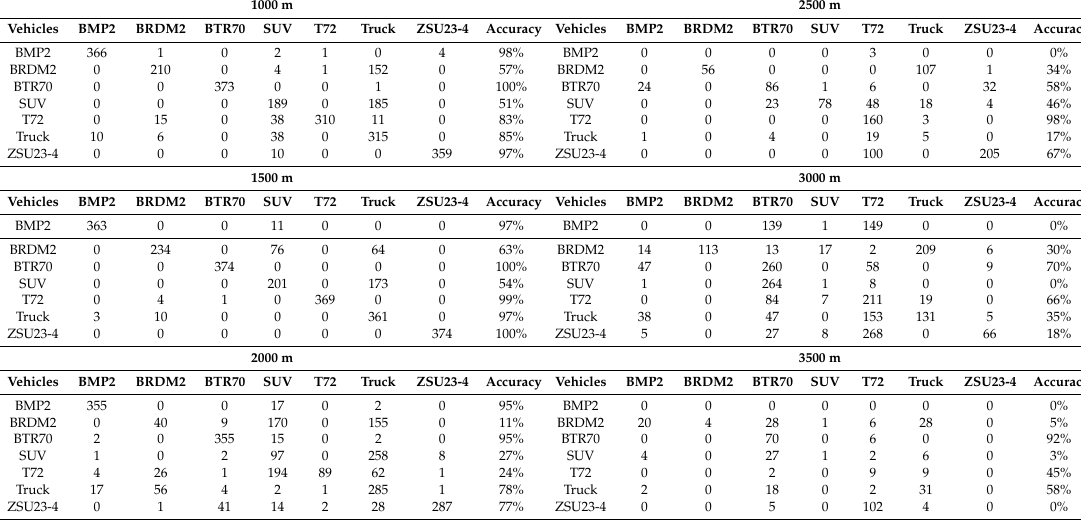
Table 3. Classification results for PCE full (optical) case. Left shows the confusion matrix and the last column shows the classification accuracy.